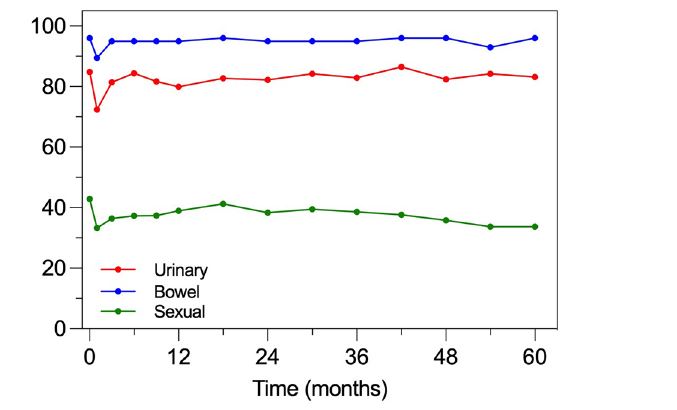
FIGURE 9 | Median EPIC-26 summary scores for the urinary, bowel, and sexual domains. EPIC-26 summary scores range between 0 and 100, with higher scores indicating